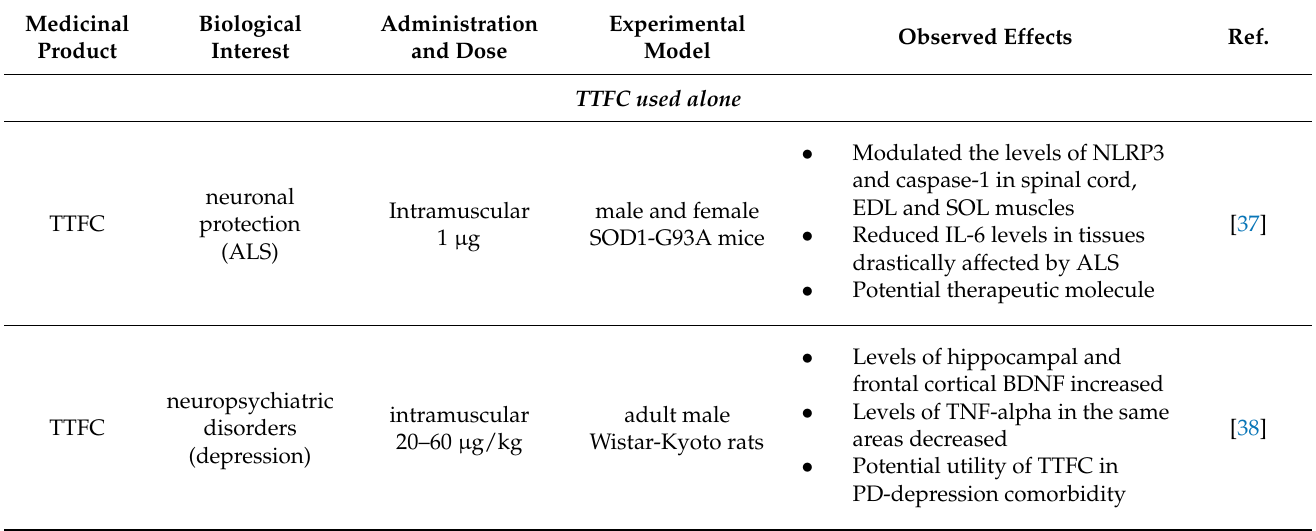
Table 2. Non-exhaustive list of in vivo uses of TTFC for neurological applications between 2005 and